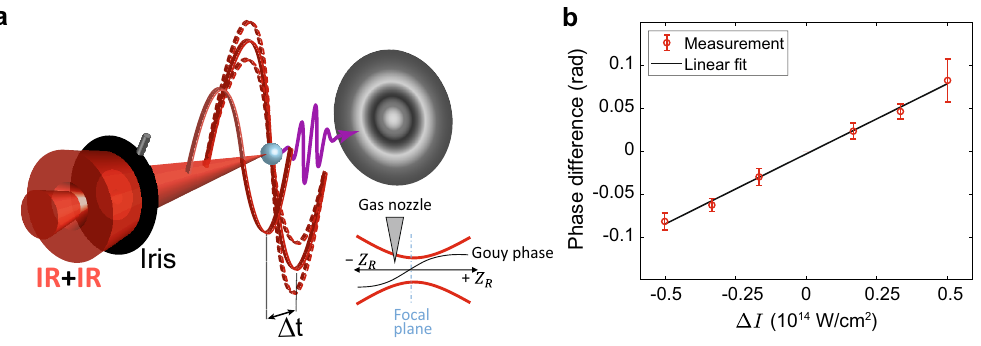
Figure 6. Measurement of the Gouy phase variation. (a) Experimental scheme. By turning off the reference HHG source and removing the Al filter, we induce an interference between the inner and outer parts of the IR beam. Scanning the relative delay leads to oscillations of the HHG signal at the target gas nozzle with the IR frequency ω IR . Varying the iris affects only the outer part of the IR beam, which enables us to determine the Gouy phase shift as a function of iris size from the Fourier analysis of the HHG signal oscillations. (b) Experimental Gouy phase variation as a function of the intensity variation (cid:31) I . The black line represents a linear fit to the experimental data (red